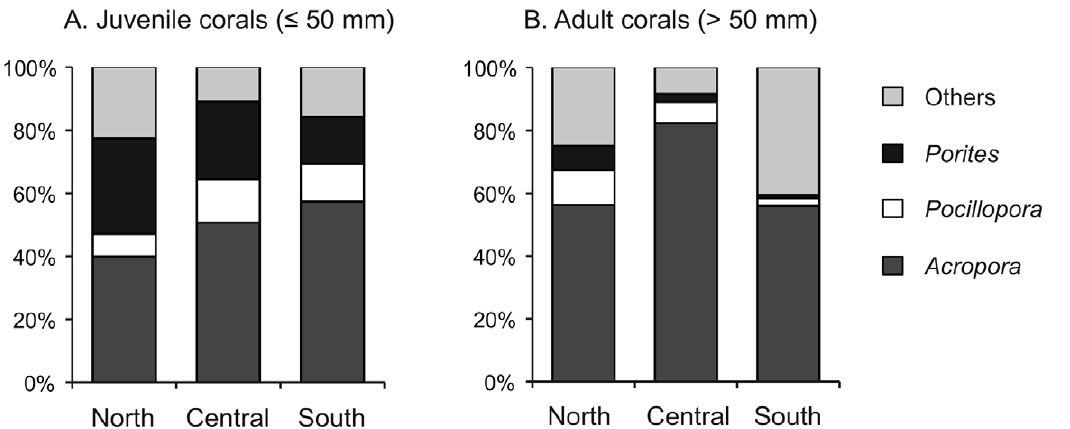
Figure 3. Relative abundance of Acropora , Pocillopora , Porites and other corals in (A) the juvenile ( # 50 mm) and (B) adult assemblages among the three sectors.